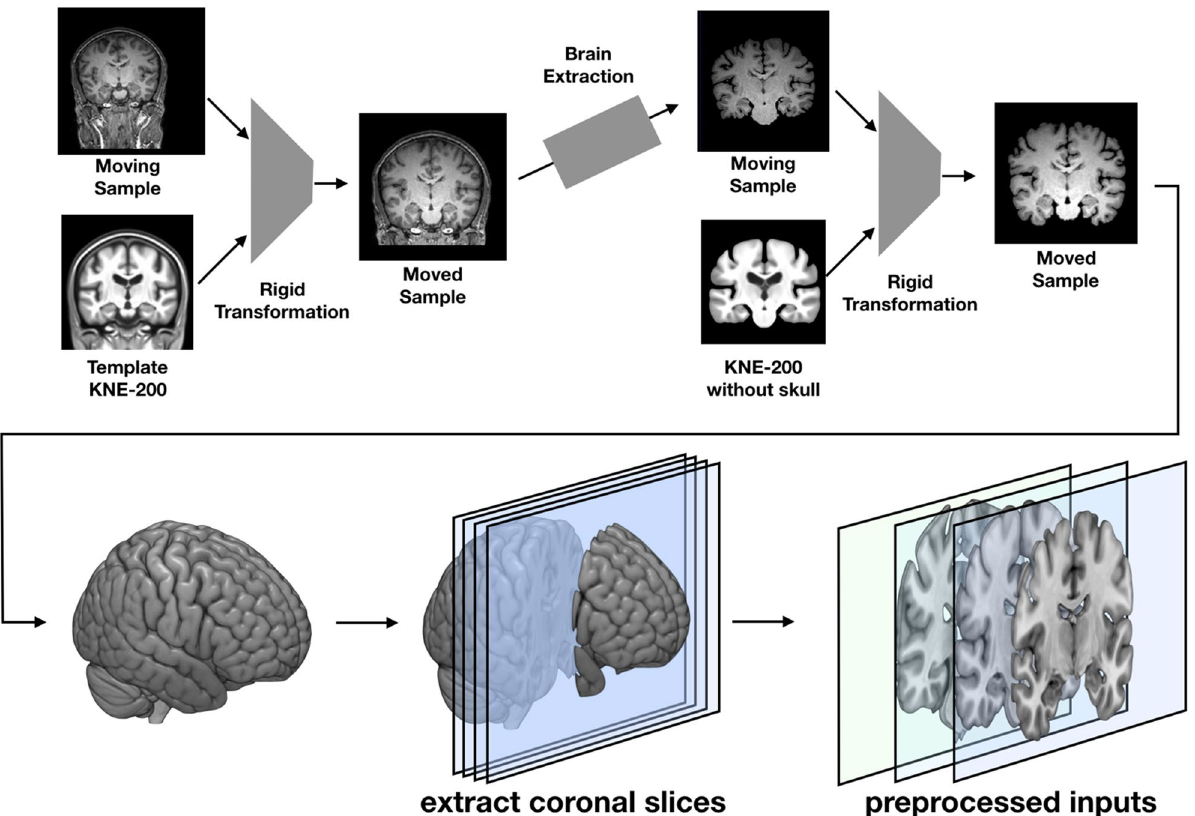
Figure 1. Preprocessing for extracting 2D coronal slices of the medial temporal lobe from complete 3D brain scans. The input whole-brain 3D T1-weighted MRI images are subjected to an initial rigid transformation to fit a template, followed by brain extraction (skull stripping). Next, a second rigid transformation is applied to the skull-stripped version of the template. Once the subject image is in the same space as the template, the range of slices that correspond to the MTL in the template are used to extract coronal slices from the template-registered output subject